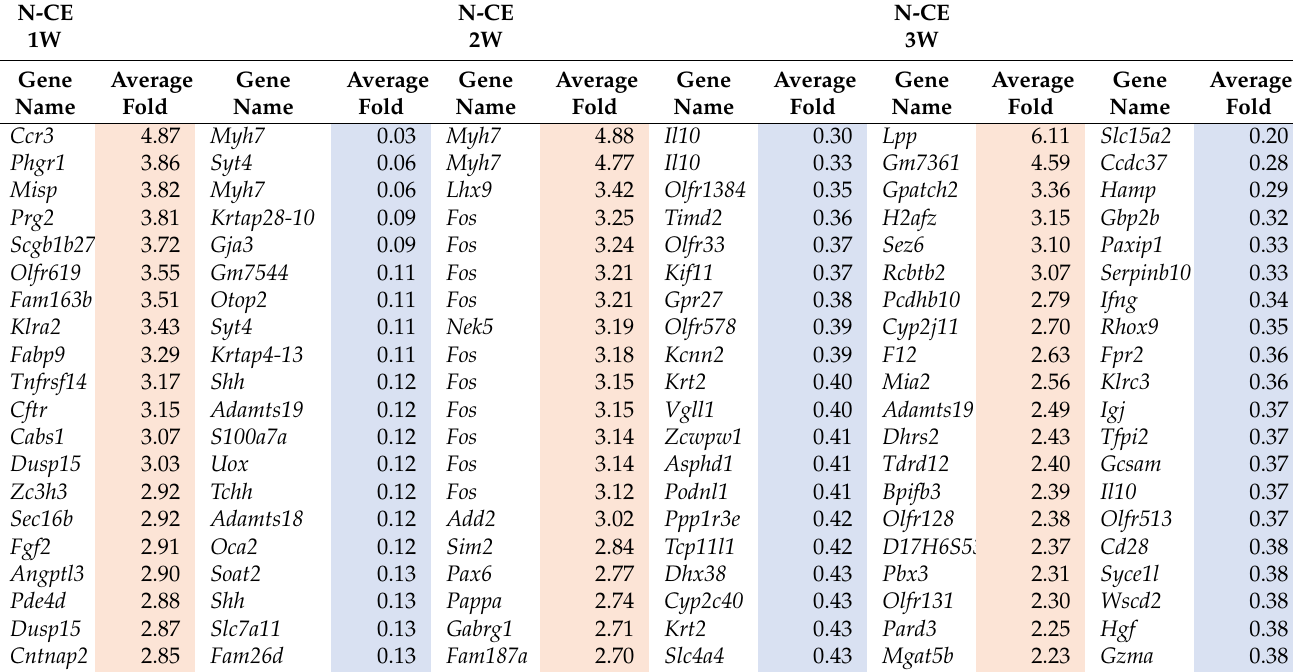
Table 3. Top 20 variable genes changed by N-CE at 1W, 2W, and 3W post-treatment.